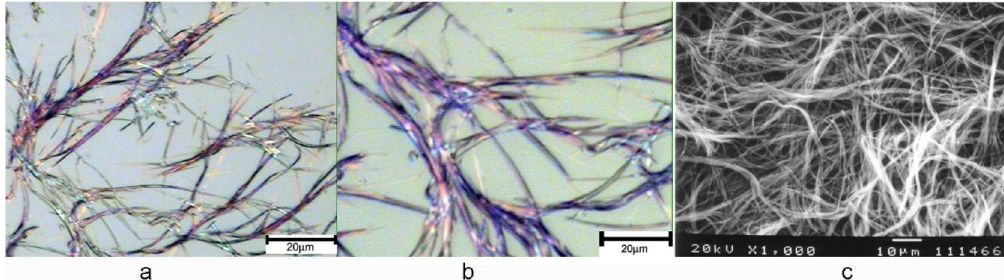
Figure 62. Optical micrographs of the ethanol gel in Figure 61 by compound 105f under bright field ( a , b ) and scanning electron micrograph ( c ). These gels were prepared by transferring the ethanol gel after UV treatment for 3 min. Reprinted with permission from [31]. Copyright 2011 Beilstein- Institut.